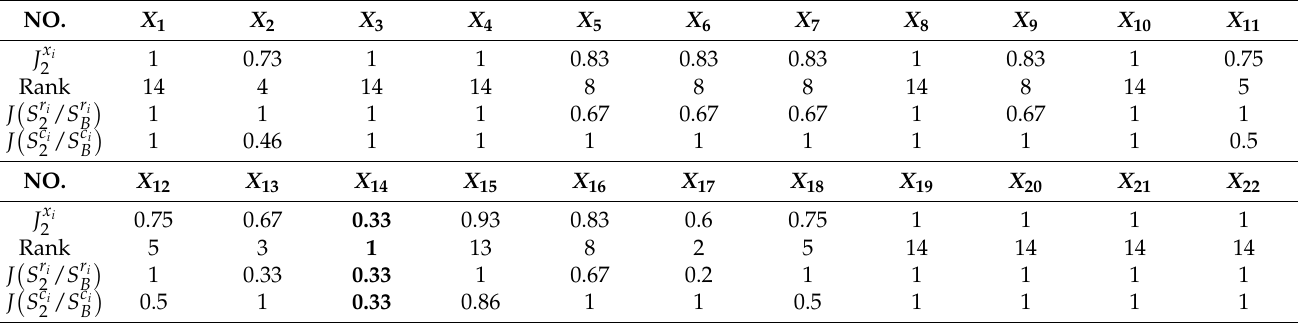
Table 15. Details of group consensus index CCG .